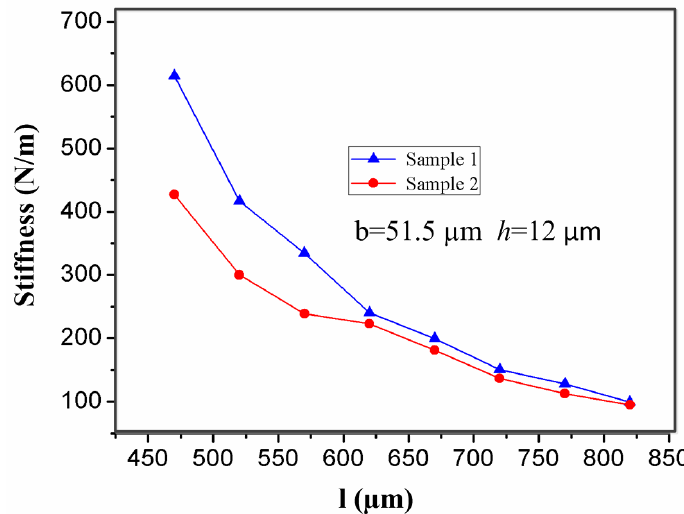
Figure 11. Effect of the length ( l ) of the stationary electrode on its stiffness when the width ( b ) and the thickness ( h ) of the stationary electrode are 51.5 µm and 12 µm, respectively.